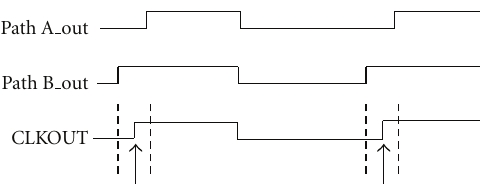
Figure 5: Function of the